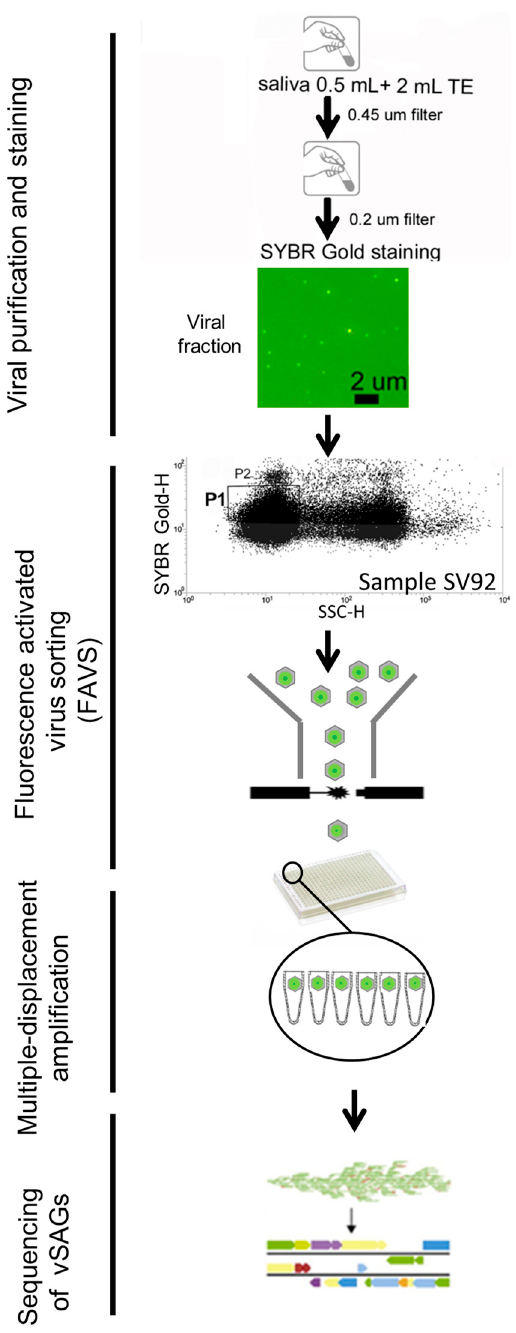
Figure 1. Schematic workflow of single-virus genomics of saliva. Salivary samples were previously filtered to remove eukaryotic cells and bacteria. Viral particles were stained with SYBR Gold. Epifluorescence microscopy imaging of the viral fraction (sample SV92) confirmed the presence of viruses. Single viruses were sorted out by fluorescence-activated virus sorting (FAVS). Flow cytometry plot for the human salivary sample SV92 (see blank in Figure S1): for each sample, the flow cytometric plot of 90 ◦ light scatter (SSC-H; height value) and green fluorescence (SYBR Gold-H; height value, relative units) is shown. Gate P1 was used for sorting of single viruses. Viruses of gate P1 clearly outnumbered those in gate P2 (see Figure S1 for more details), and as this study was focused on viruses which are dominant and abundant in the oral cavity, single-virus genomics was performed only on sorted viruses from gate P1. Whole genome amplification of sorted single viruses was achieved by multiple displacement amplification. Positive viral single-amplified genomes (vSAGs) were sequenced by Illumina technology, and further assembled and analyzed.